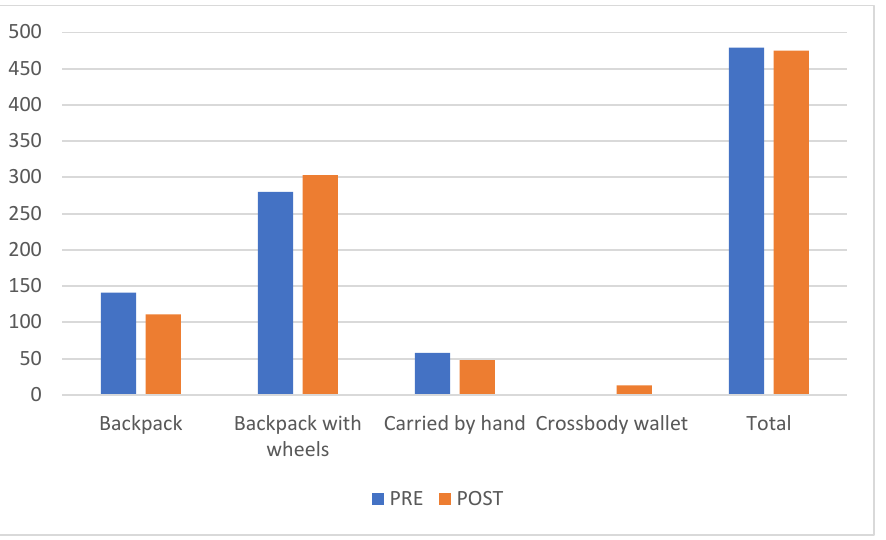
Figure 3. Descriptive analysis number and percentage (%) of the means of carrying school materials used by students pre- and